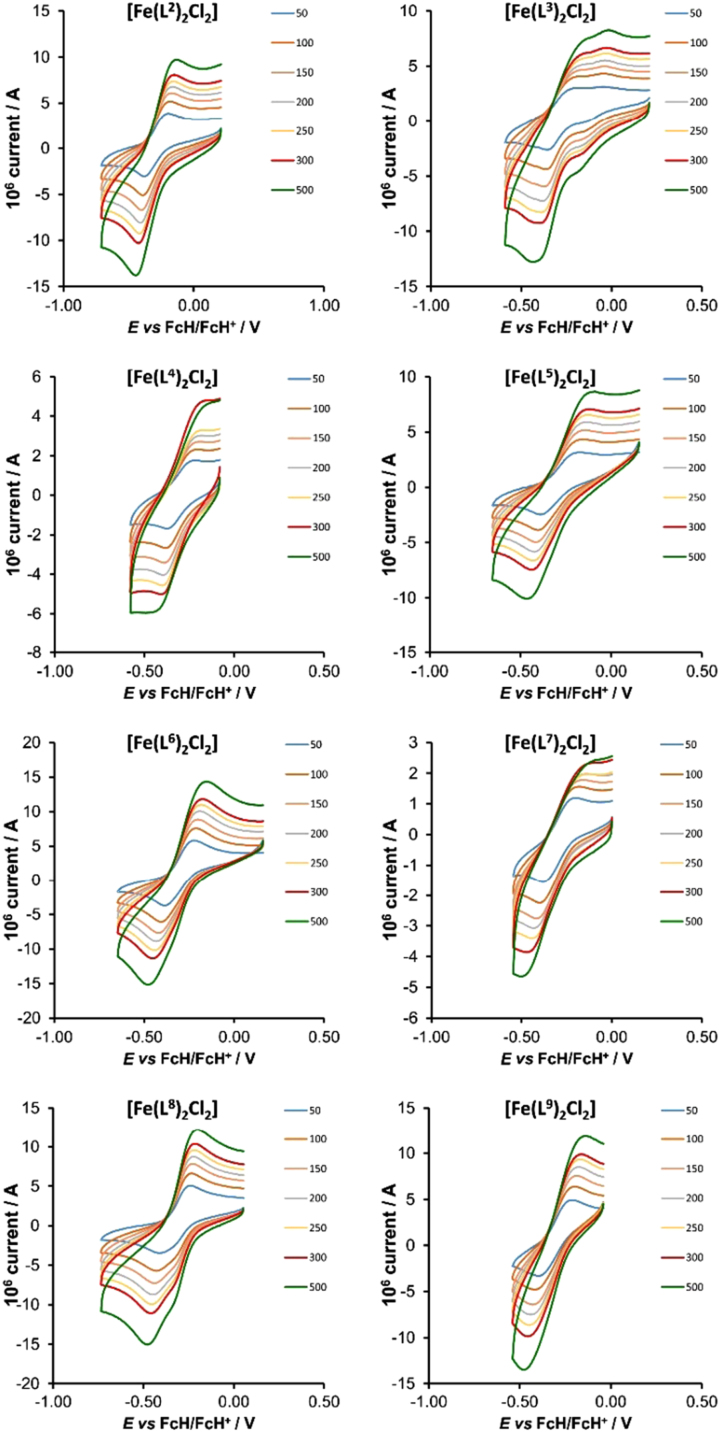
Cyclic voltammograms of the FeII/III redox couple of dichloro(bis{2-[1-(4-R-phenyl)-1H-1,2,3-triazol-4-yl-κN3]pyridine-κN})iron(II) coordination compounds [Fe(Ln)2Cl2 at scan rates of 0.05 (lowest peak current) – 0.50 (highest peak current) Vs-1 (0.10 Vs-1 scans from [1]). All scans initiated in the positive direction. R=CH3 (L2), OCH3 (L3), COOH (L4), F (L5), Cl (L6), CN (L7), H (L8) and CF3 (L9). Values E°׳ (V vs. Fc/Fc+) at 0.100 V s-1=−0.287, −0.282, −0.296, −0.281, −0.311, −0.295, −0.333 and −0.310 V [1], for complexes 2 to 9 respectively. CV׳s obtained in 1:3 acetonitrile/DMSO solution with 0.1 mol dm−3 (nBu4N)(PF6) as supporting electrolyte.